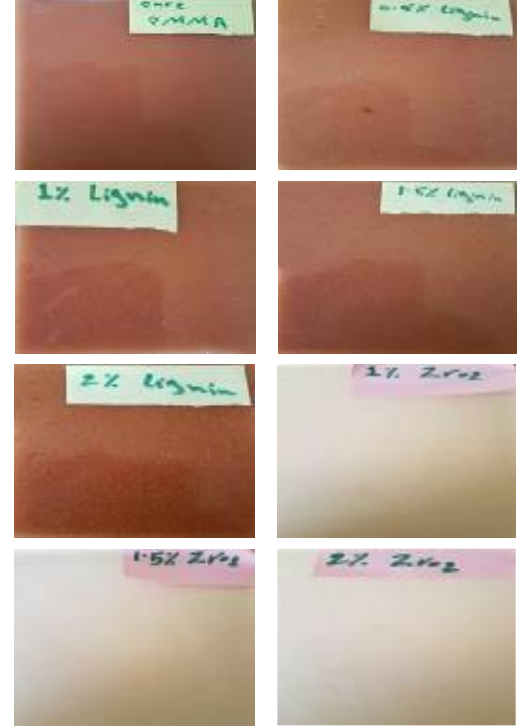
Fig. 10. Shows the Composites Prosthetic Dentures Specimens for Pure PMMA and PMMA